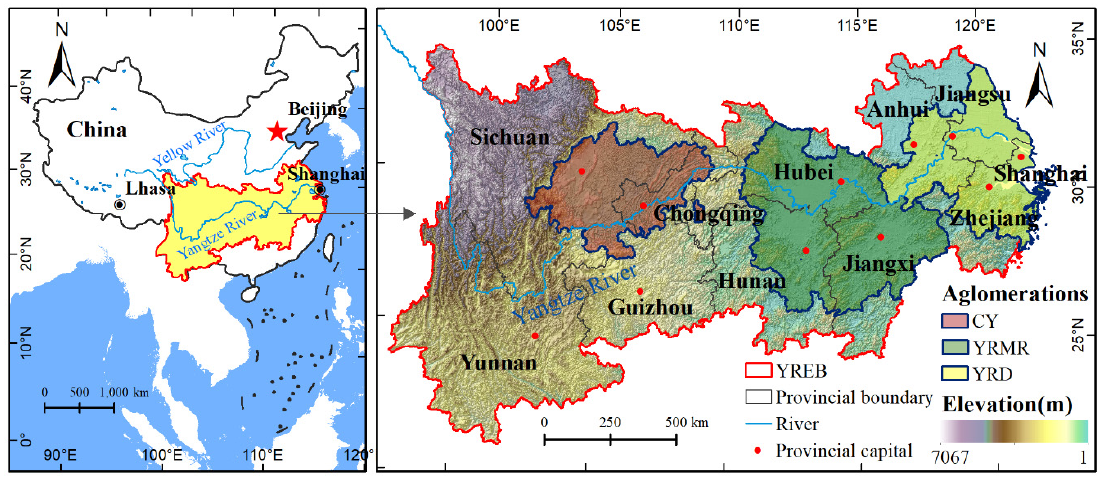
Figure 1. Geographical location of the study area.